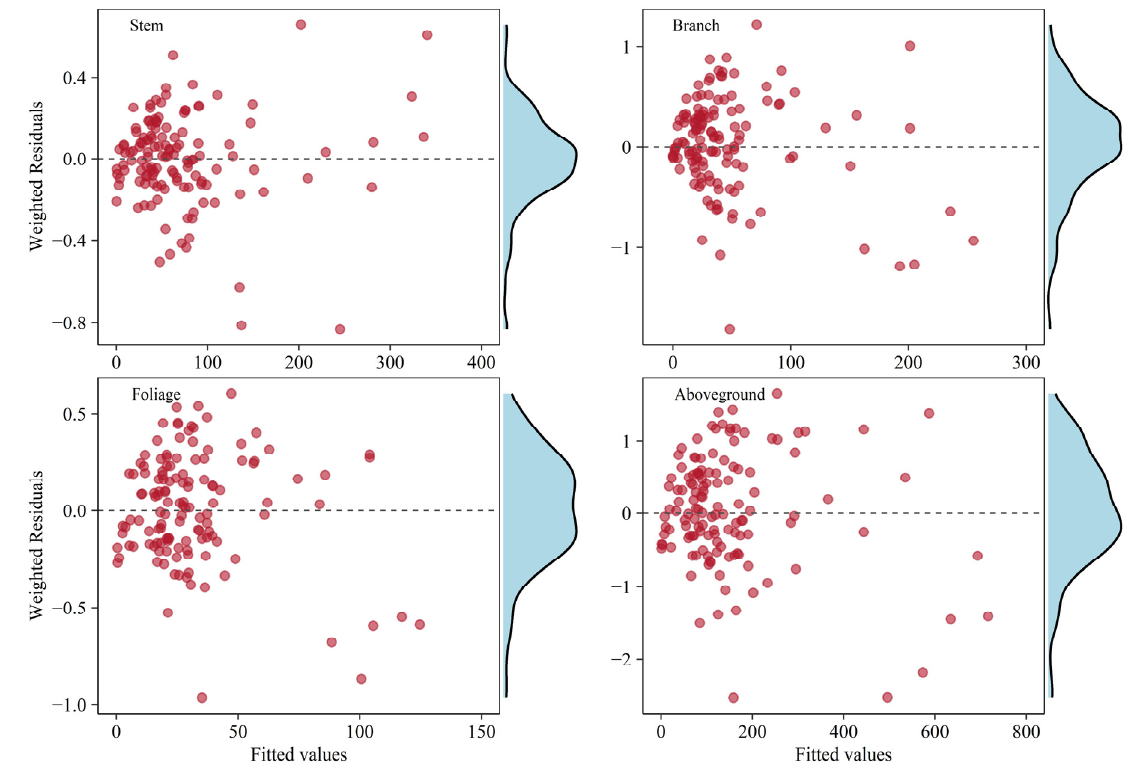
Figure 4. Weighted residual plots for each biomass component in the system of equations fitted with the WNSUR procedure. The density diagram on the right side indicates residual distribution.